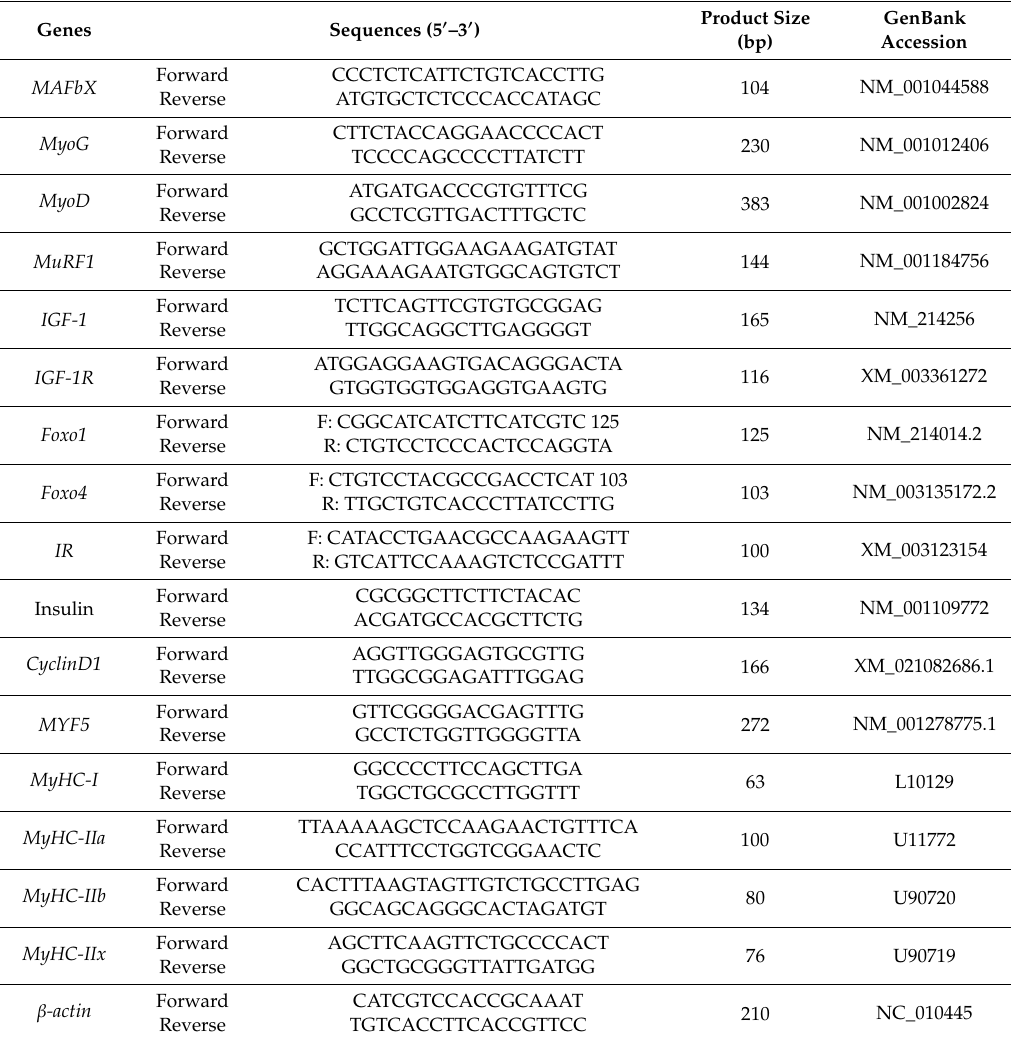
Table 2. Primer sequences used in this